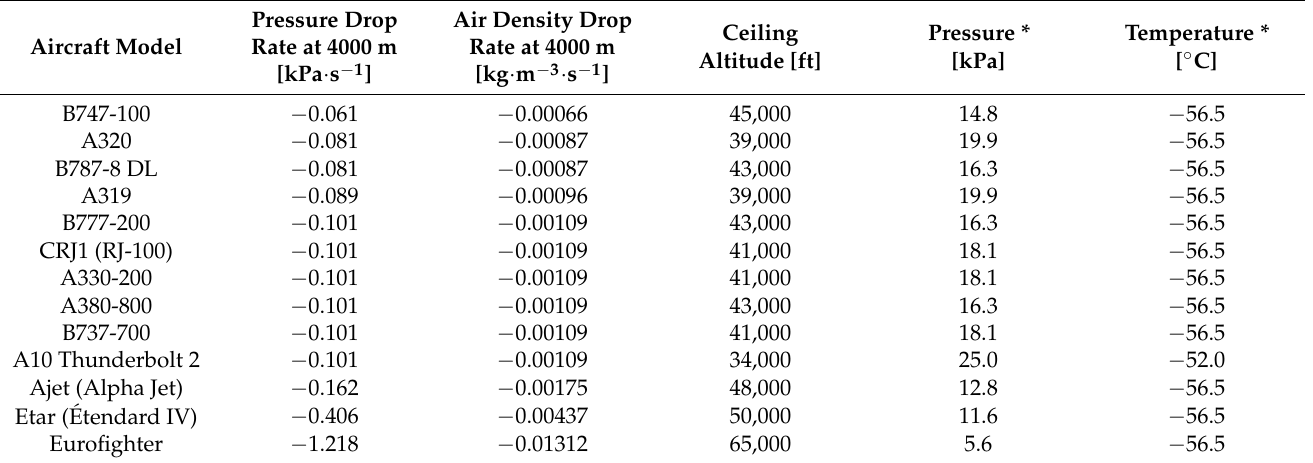
Table 1. Approximate pressure drop rate during climb at 4000 m altitude for various aircraft